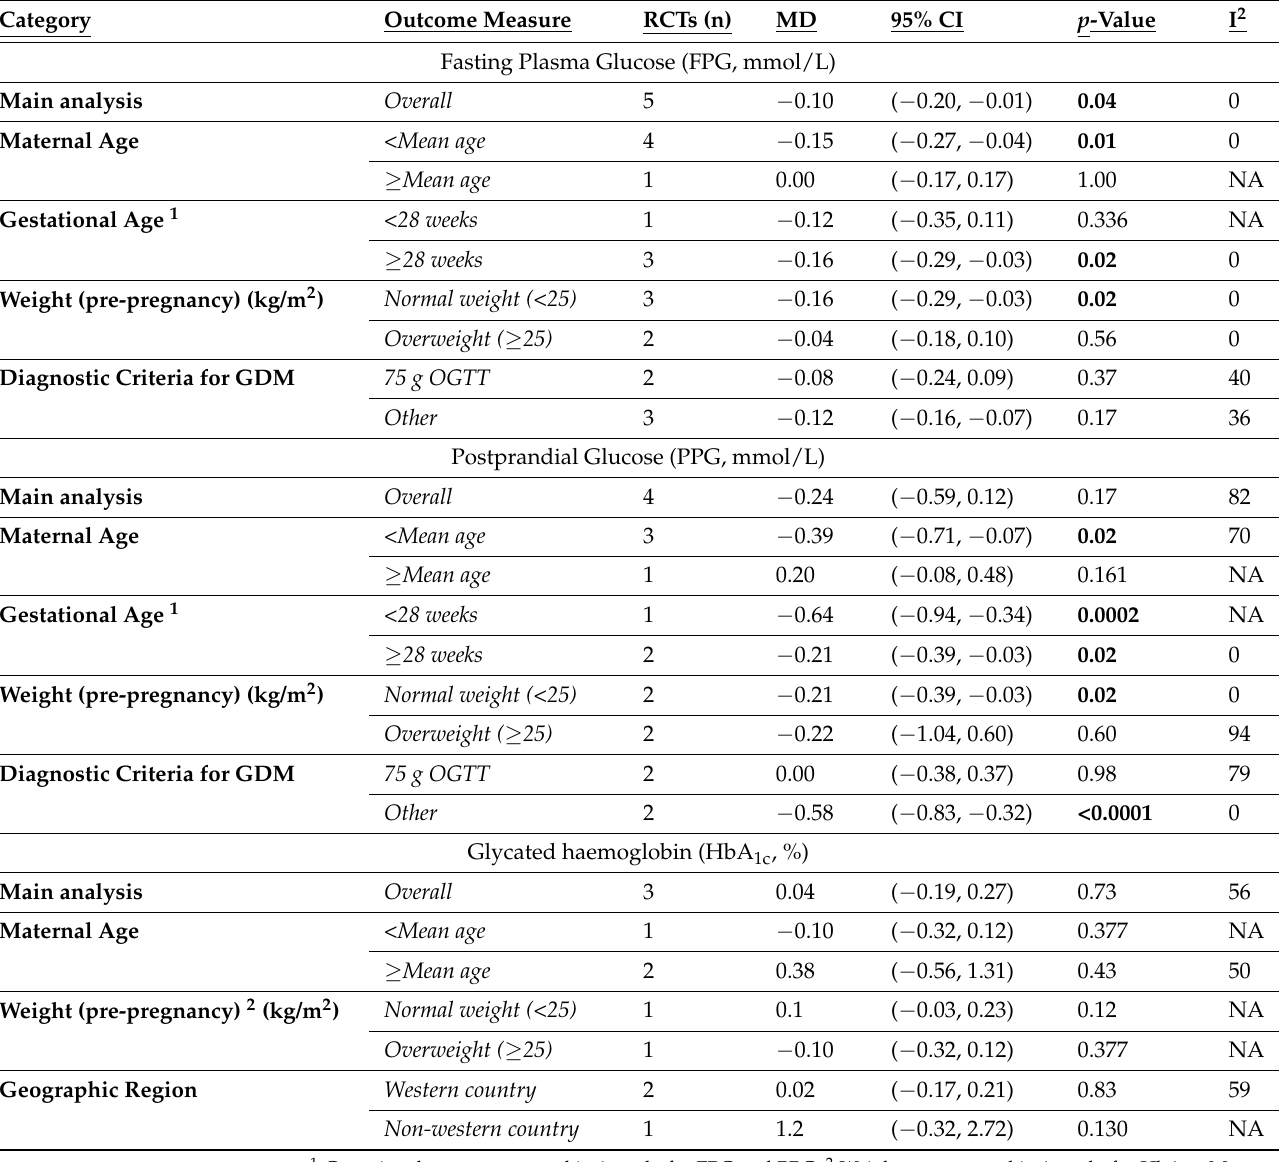
Table 6. Subgroup analysis of exercise vs. control